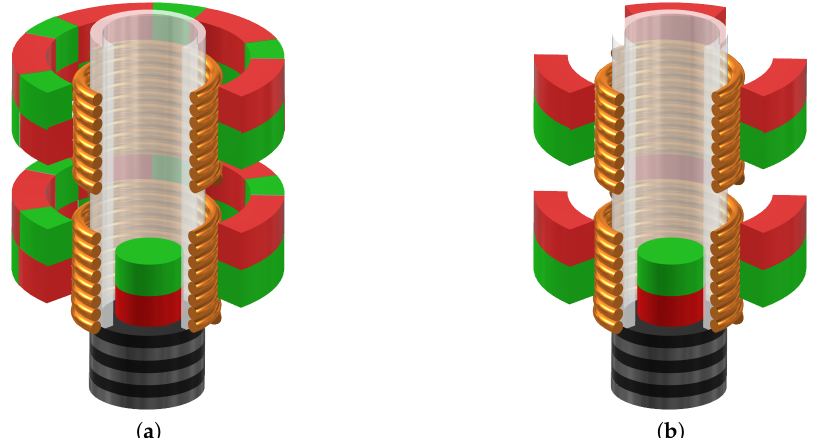
Figure 6. Alternative concepts for achieving suitable magnetic force characteristics. ( a ) A Halbach array-like magnet design may be used to weaken the magnetic field. ( b ) Multiple single magnets can be used instead of a small ring